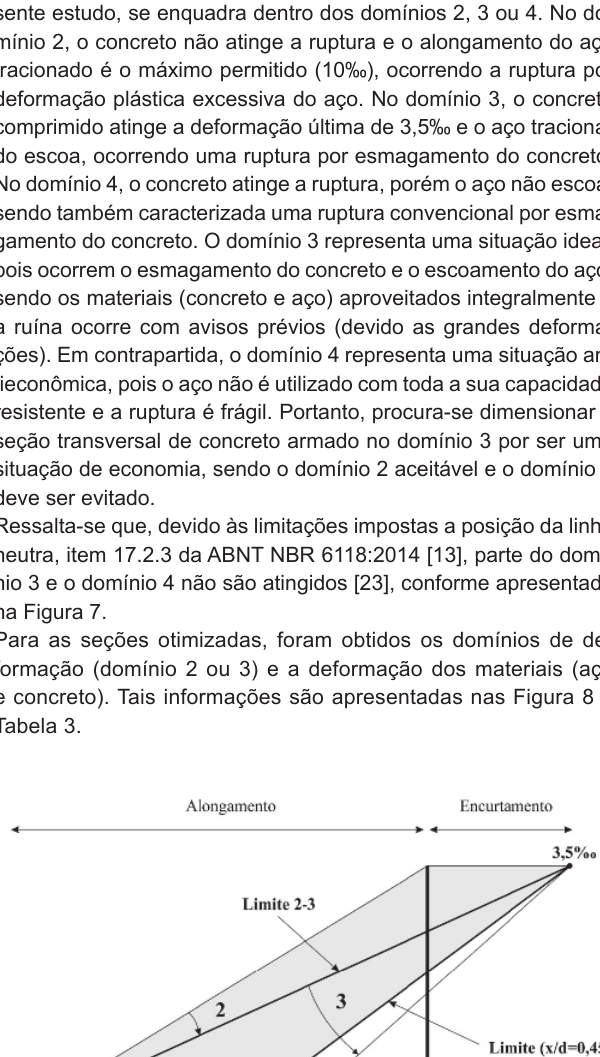
Figura 7 Domínios de deformação possíveis na flexão simples, para f menor ou igual a 50 ck